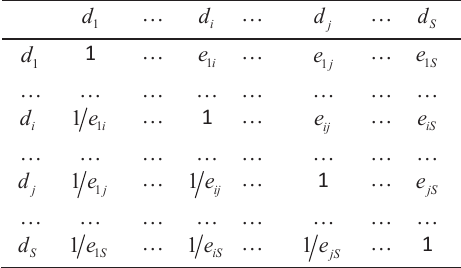
Table 2. Standard pair-wise comparison